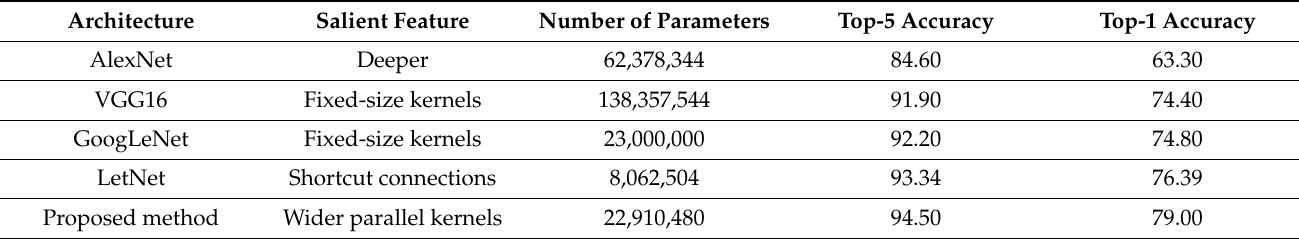
Table 2. Comparison among various methods.